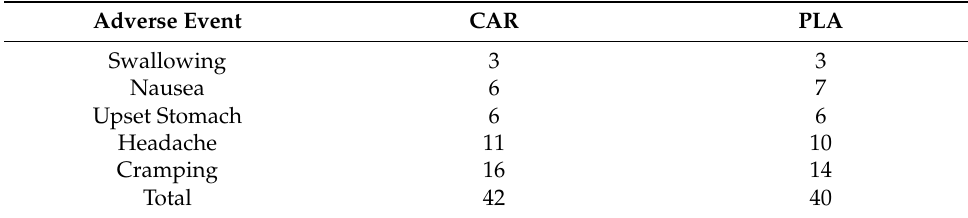
Table 2. Adverse Events